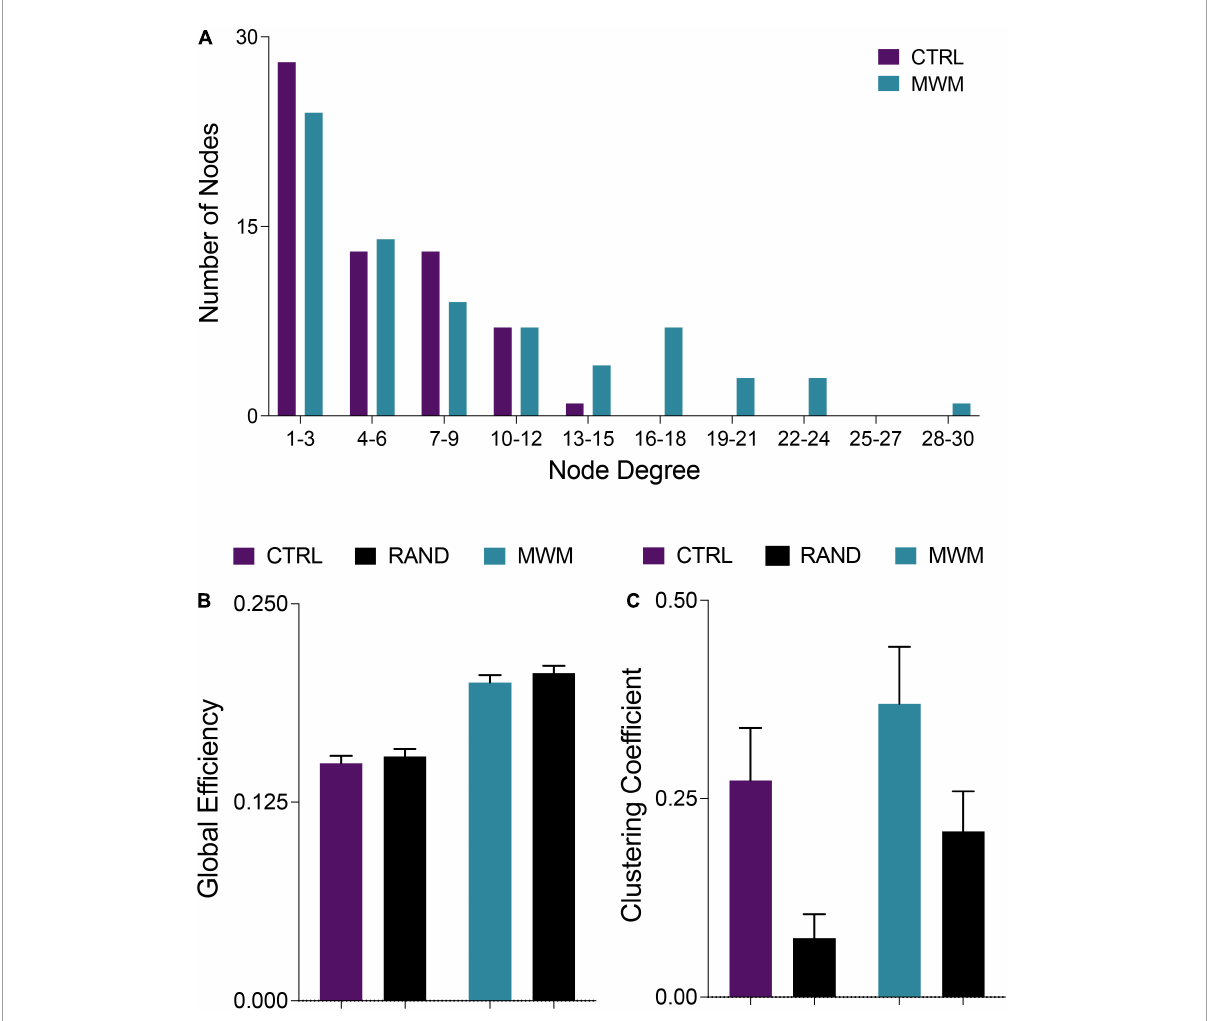
FIGURE4 (A) Consistent with definitions of small world organization, in both control and MWM trained networks the majority of nodes were of a low degree. However, water maze training shifted the degree distribution and increased the number of highly connected nodes. (B) Also consistent with small world organization, both control and MWM trained networks showed equivalent global efficiency to random networks matched for degree distribution. (C) A third requirement for the classification of a small world organization is a higher clustering coefficient than a random network. Compared to random networks matched for degree distribution, both control and MWM trained networks showed heightened clustering. Data shown are mean ± 95% confidence